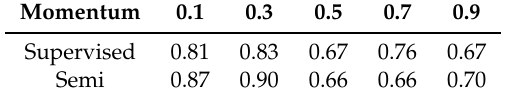
Table 13. Sensitivity Analysis (Momentum).